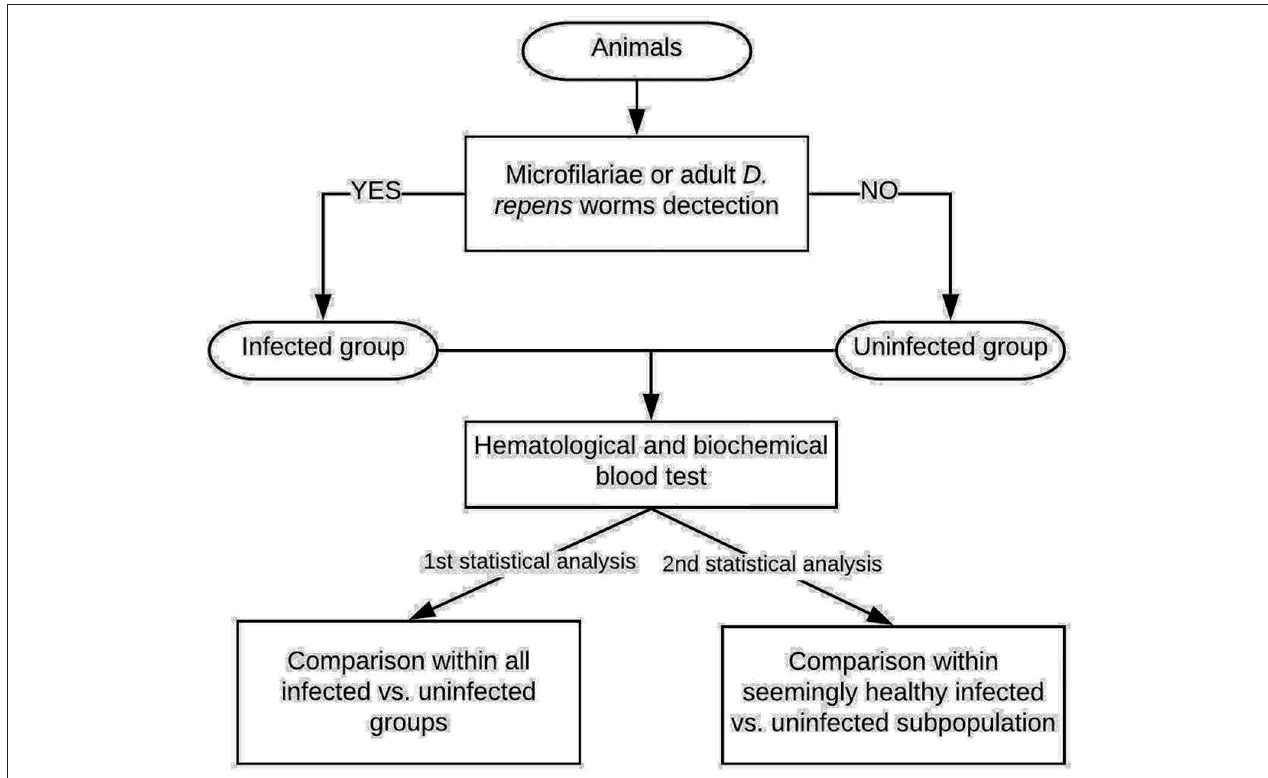
FIGURE 1 | Study design: The examined dogs were classified into the infected group based on the presence of Mf in blood smear/positive result of multiplex PCR/adult D. repens parasites found during surgery. Then, blood tests were performed on all individuals. The first statistical analysis included all patients, while the second analysis was performed on a seemingly clinically healthy subpopulation of dogs having blood check-up results within normal reference ranges.